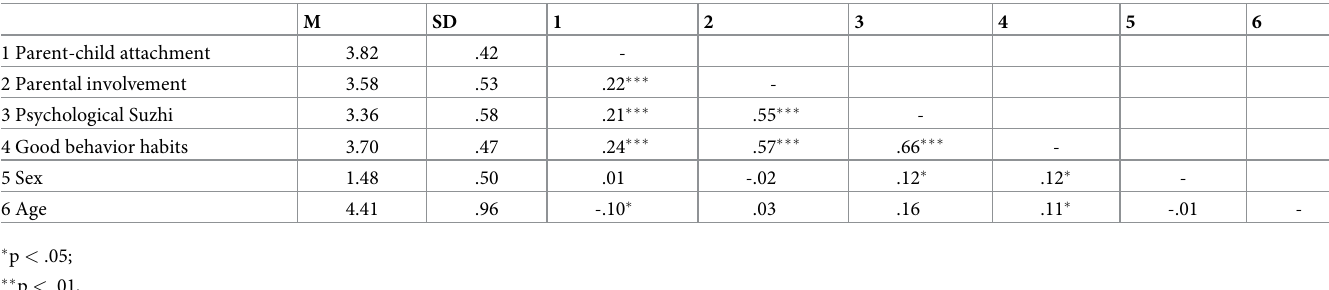
Table 1. Means, standard deviations, and correlations of all variables (n =